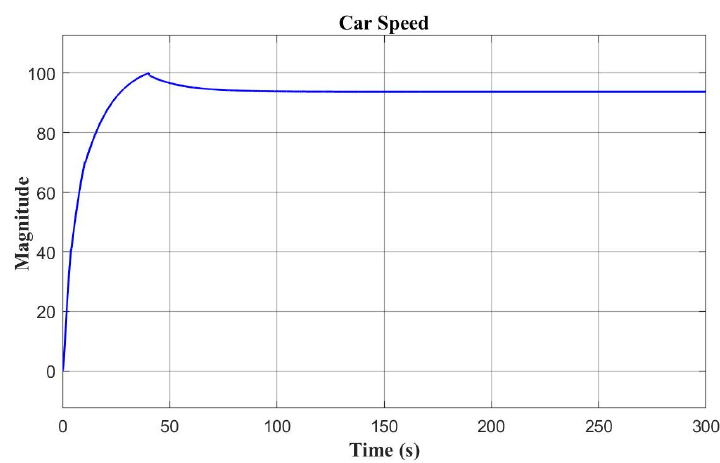
Figure 9. Autonomous vehicle speed profile without any fault.